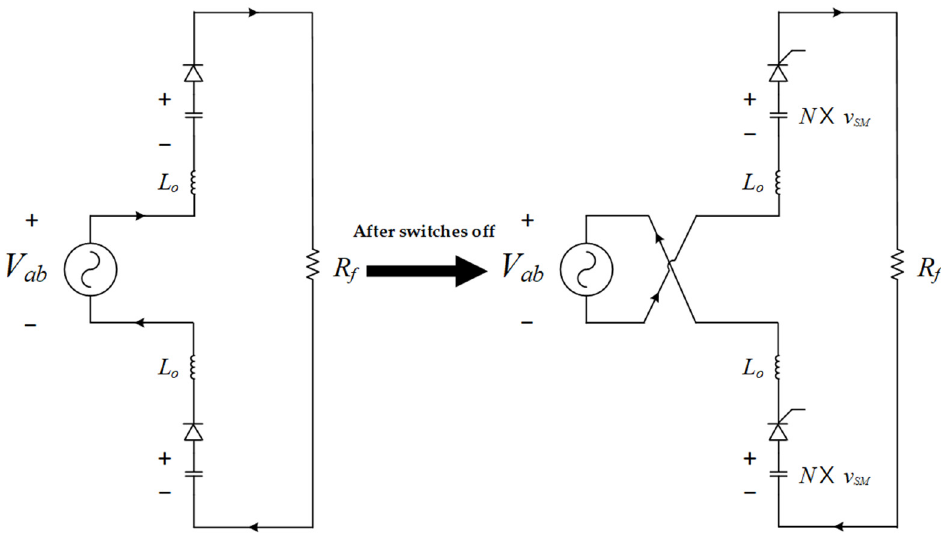
Figure 10. Circuit analysis when operating the proposed sub-modules in accordance with an FRT strategy.